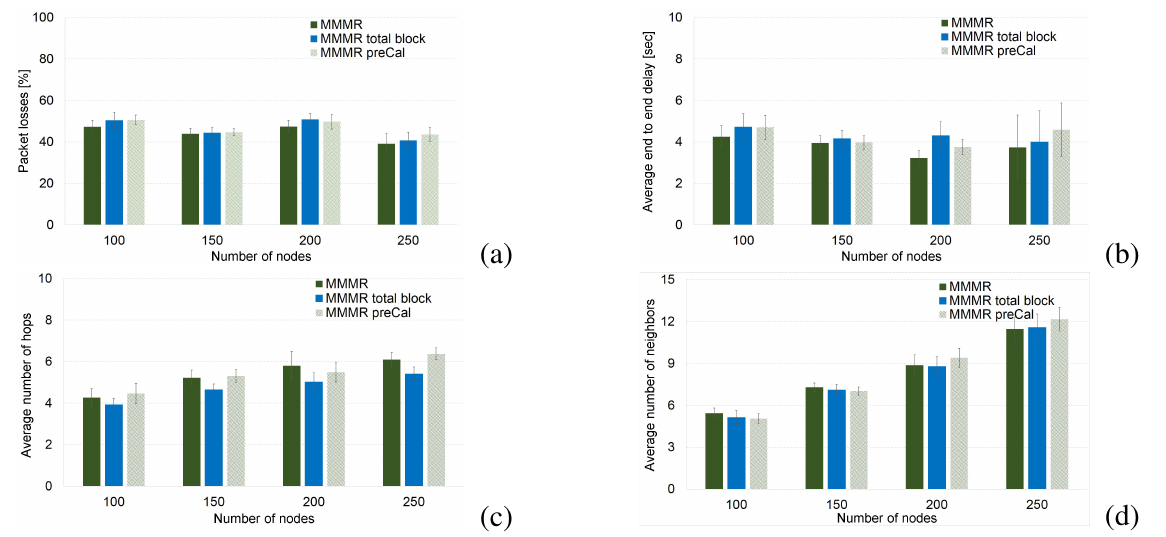
Figure 8. Building attenuation model comparison (Barcelona scenario) (CI 95%). ( a ) Percentage of packet losses; ( b ) average end-to-end delay; ( c ) average number of hops; ( d ) average number of neighbors.